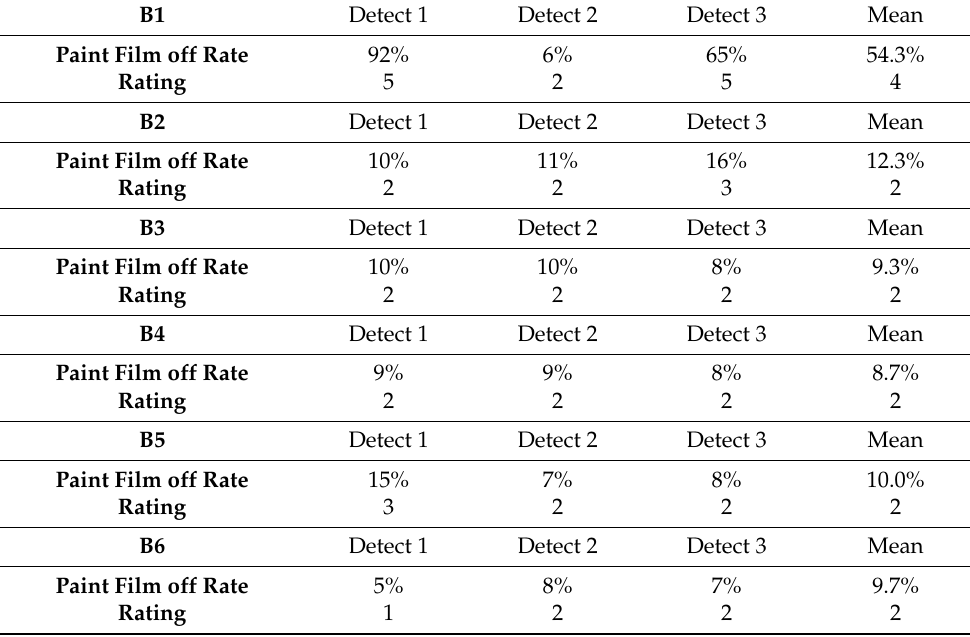
Table 10. The measured value of adhesion of paint film for Group B.